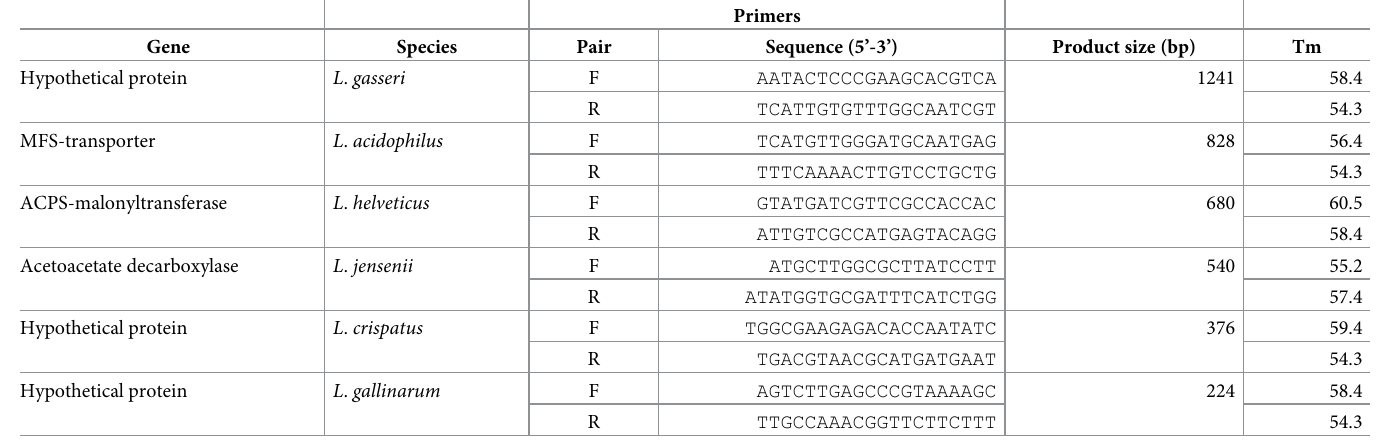
Table 3. Target genes and primers used in this